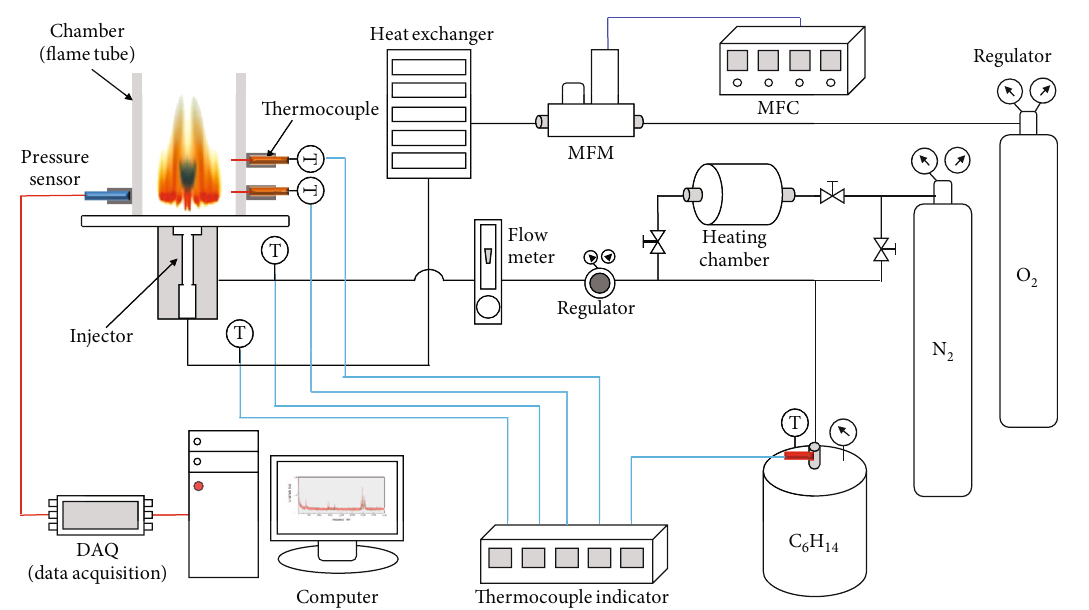
Figure 2: Schematic diagram of experimental